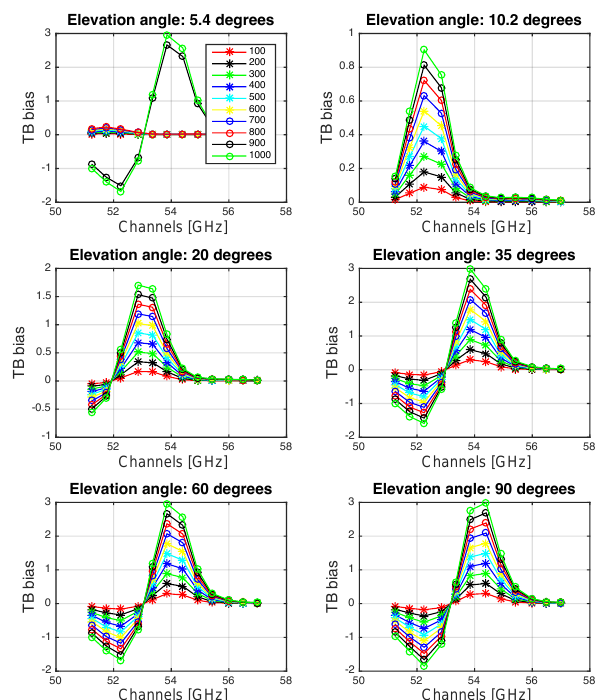
Figure 9. Errors associated with the antenna beam for different fre- quencies and elevation angles. The antenna beam was considered simulating a Gaussian response with a different HPBW (from 1 to 8 ◦ ). The biases have been calculated as the Tb s considering the pen- cil beam (PB) minus the Tb s assuming different antenna patterns (AP).